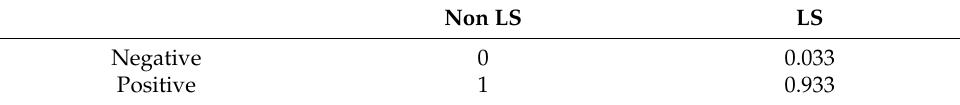
Table 7. Value of GT before and after applying Label Smoothing (NIH).